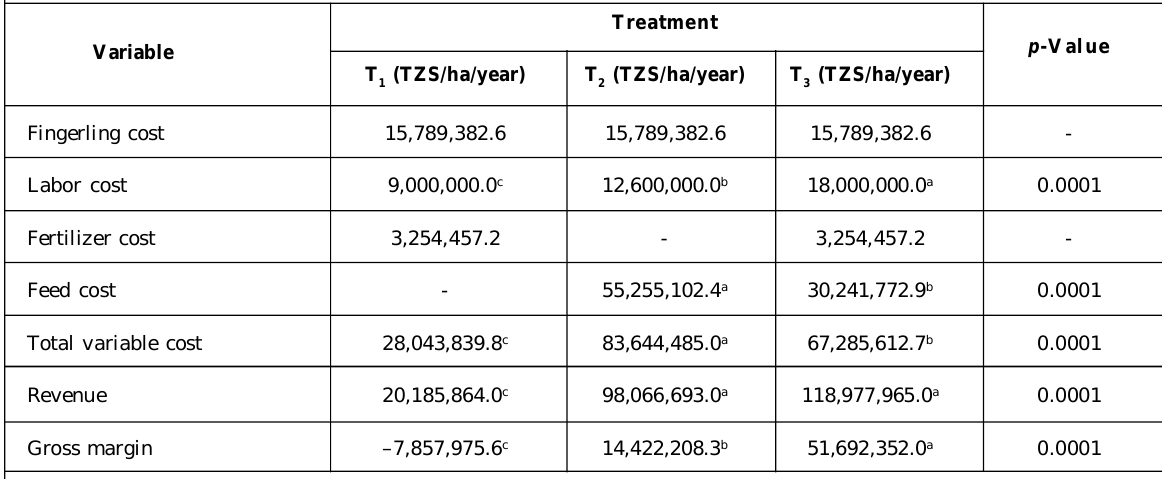
Table 3: Comparison of variable costs, revenue and profit obtained from O. niloticus cultured in concrete tanks under three different